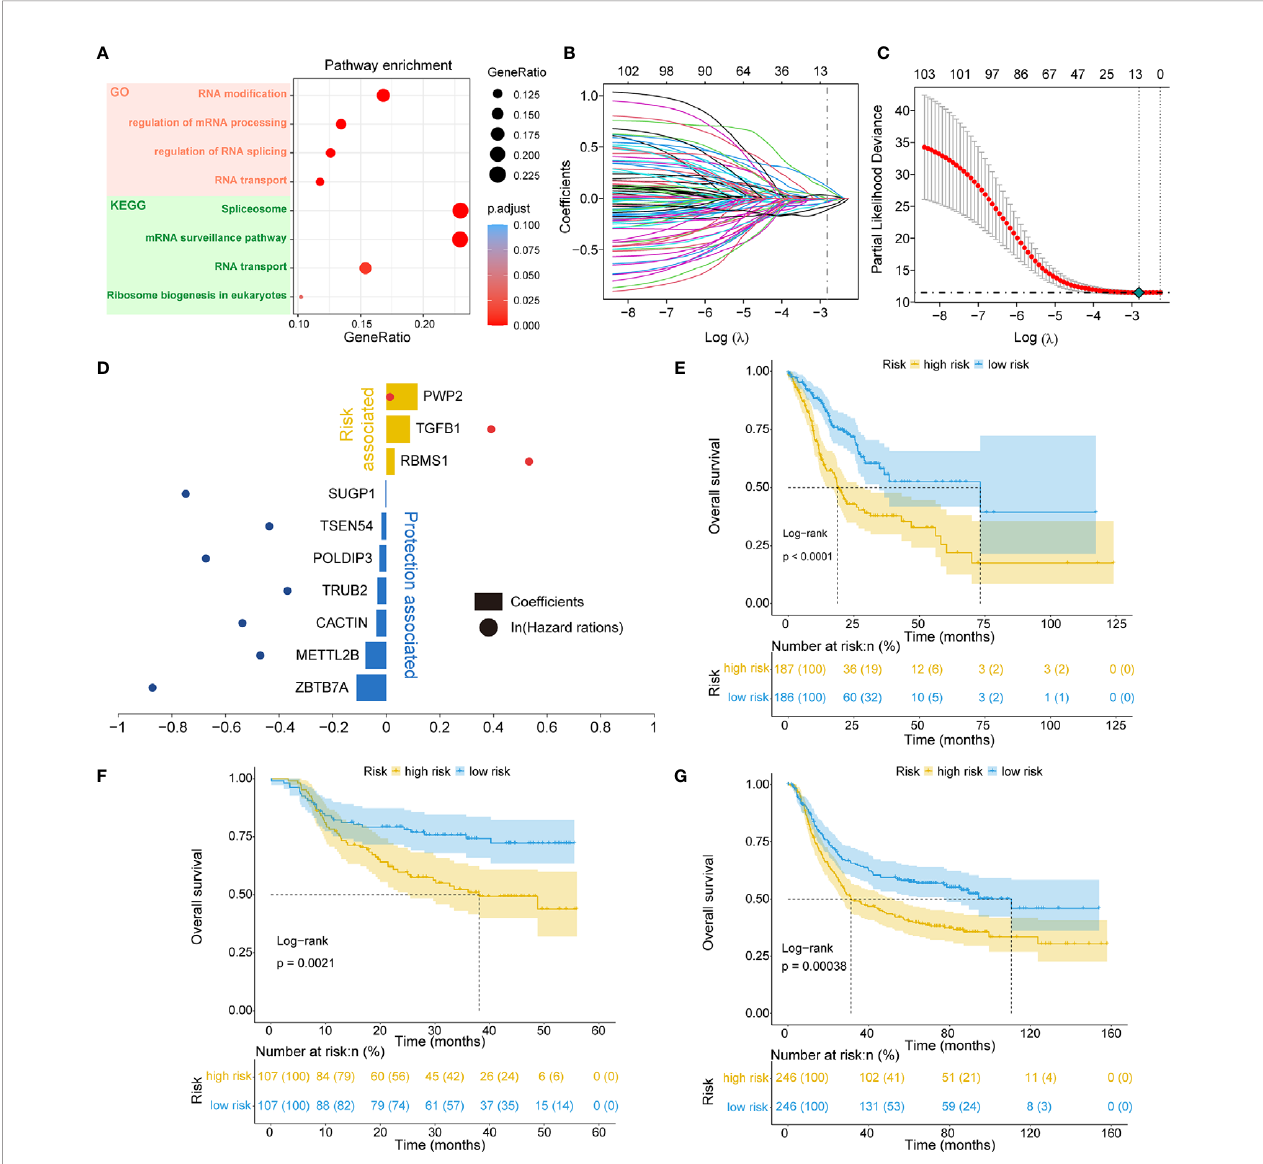
FIGURE 2 | Identi fi cation of the RNA processing-related prognostic signature. (A) Scatter plots showing functional enrichment analyses for the 105 OS-related RNA processing factors. (B, C) LASSO regression analysis of the 105 OS-related RNA processing factors. (D) The 10 genes included in the signature. Corresponding coef fi cients and HRs are depicted by horizontal bars and dots, respectively. (E – G) Kaplan – Meier OS curves with difference detection by log-rank test for patients from the training and validation